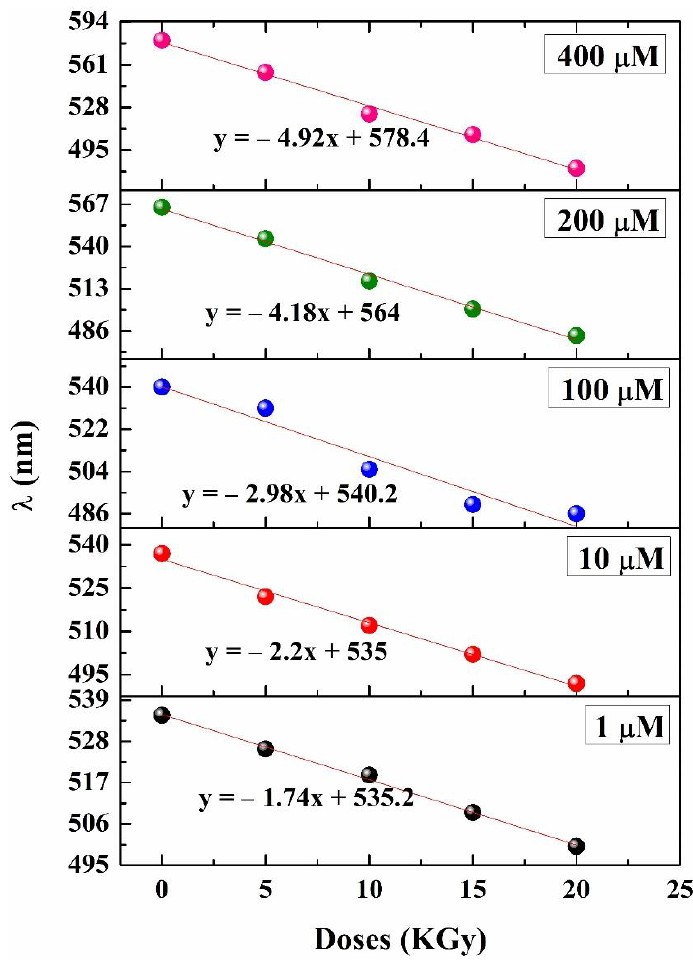
Figure 7. The main fluorescence peak wavelength (λ max ) of the B-co-MP in THF versus gamma doses for different concentrations.